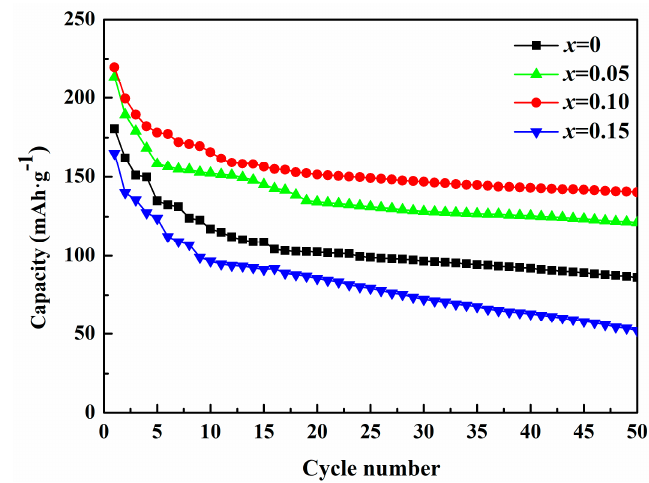
Figure 7. Cycling performances of the synthesized Li 2 Mo 1 − x Co x O 3 ( x = 0, 0.05, 0.10, 0.15) between 1.5 and 4.5 V at 5 mA·g − 1.